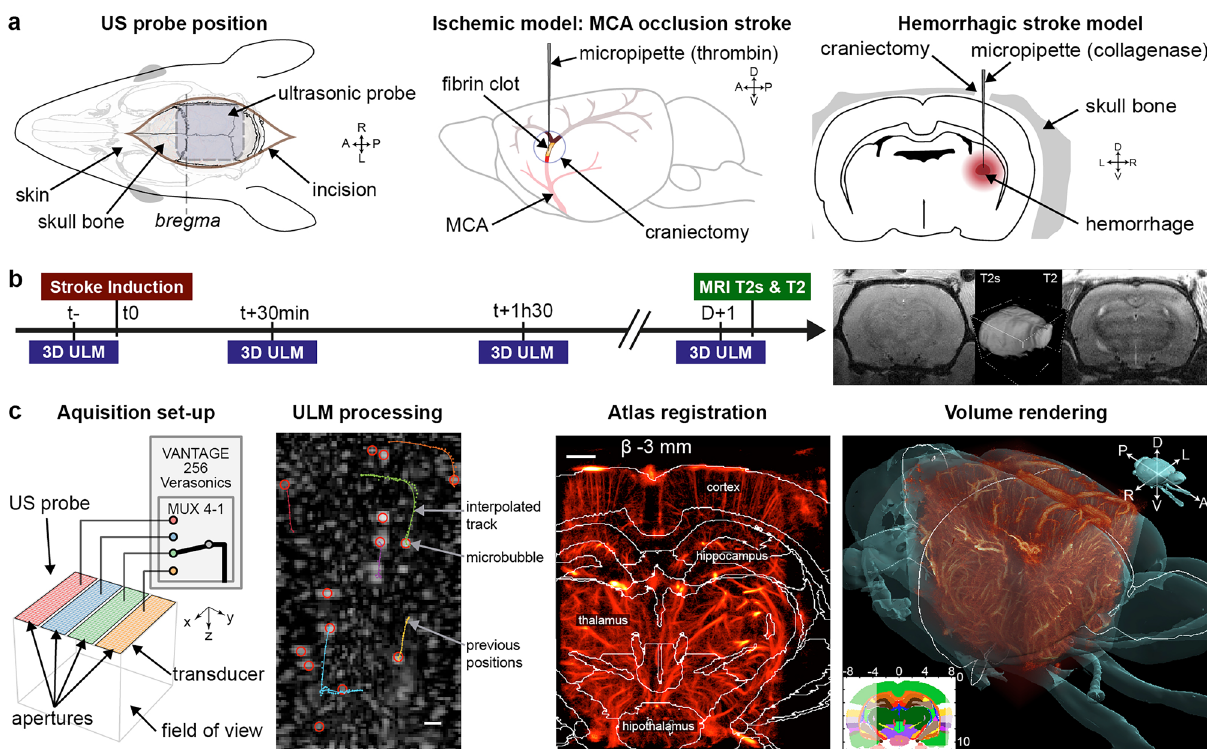
Figure 1. 3DULM for in vivo angiography at the early phase of stroke’s models. (a) Skin opening for ultrasound imaging. Ischemic model: a small hole was drilled above the MCA branch, and human thrombin was injected. Hemorrhagic model: the parietal bone was drilled, and collagenase was injected in the striatum. ( b) Timeline of the experiment for each model, with four acquisitions: in the half hour prior stroke onset (t−), in hyperacute stage (30 min and 1h30), and the day after with MRI imaging. T2* and T2 MRI sequences slices and 3D rendering. ( c) Ultrasound matrix probe with transducers pooled in four synthetic apertures successively connected to the echograph. ULM processing with filtering, localization and tracking. Rat brain atlas registered on ULM volume (600 µm width slab). 3D rendering with brain surface with Amira software (Thermo Fisher). Scale bars: 1 mm. Figures were created with ( a–c ) Illustrator 2021 (https:// www. adobe. com/ produ cts/ illus trator), ( c ) MatLab 2019a (https:// www. mathw orks. com/ produ cts/ matlab), ( c ) Amira 2019.4 (https:// www. therm ofish er. com/ amira-